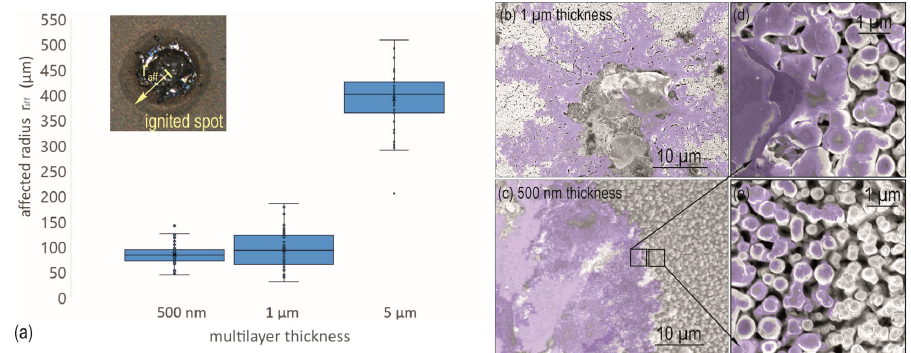
Figure 2. Affected zone dependent on layer thickness on nanostructured surface. ( a ) box plot of the affected radius measured by light microscope as function of layer thickness; ( b ) false color SEM image of ignition zone; zone is minimal larger and has dendrite shape, form is irregular, fractal distribution of the ignition over nanostructures on top, molten areas are colored; ( c ) false color SEM image of 500 nm layer. Ignited zone has a round shape, molten area ends abruptly; ( d ) detail of the border area, molten layers on top are depicted in false color; ( e ) outermost area of influenced zone, some tips show fused structure (false color).